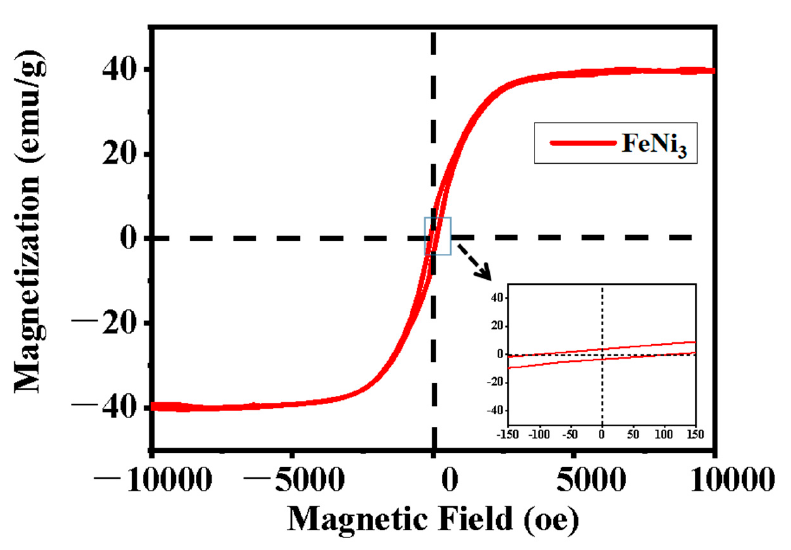
Figure 7. Hysteresis line diagram of FeNi 3 alloy.